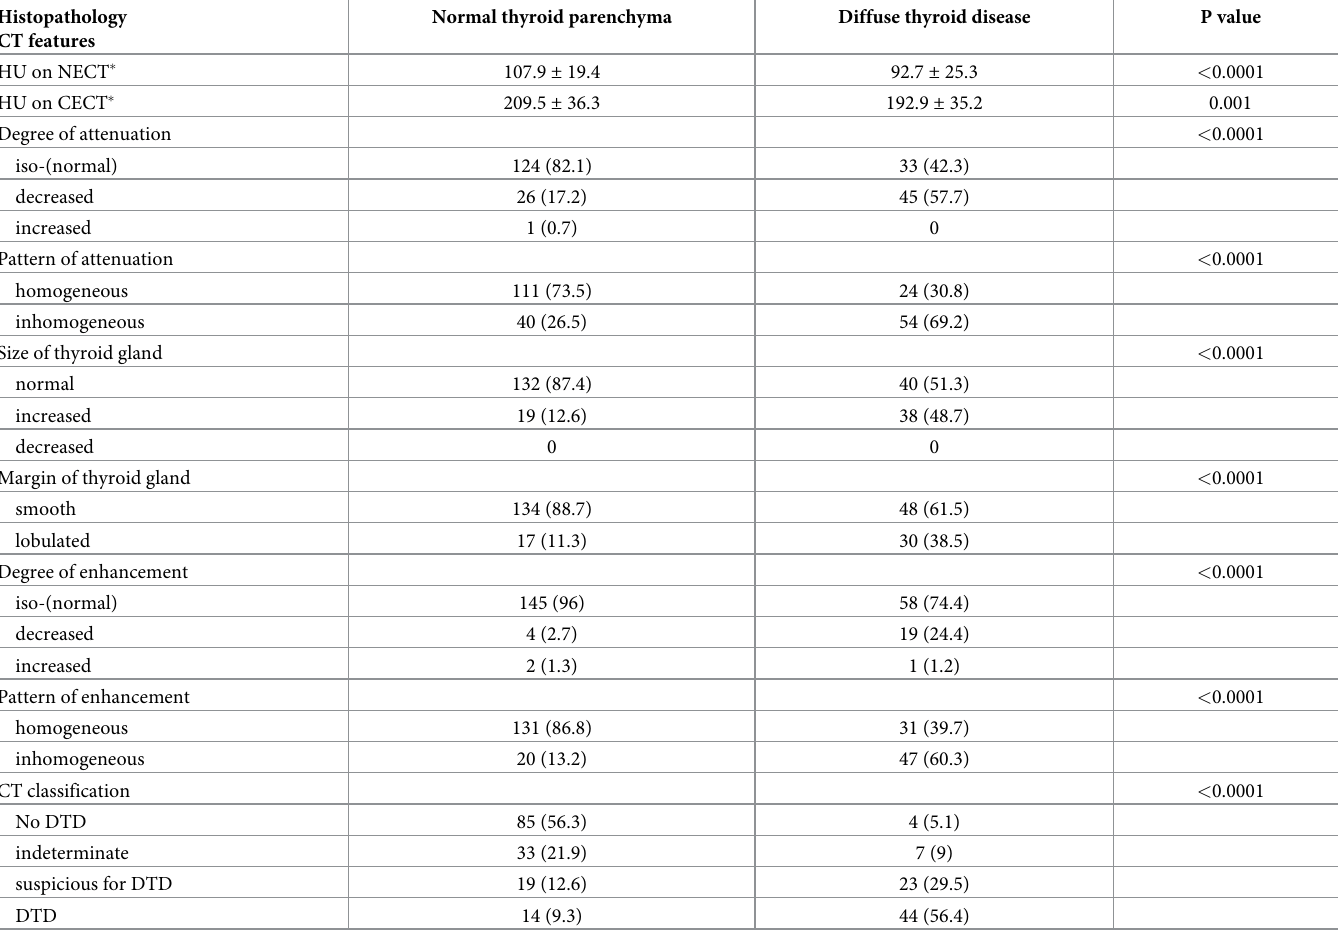
Table 1. Comparison of the computed tomography features of normal thyroid parenchyma and diffuse thyroid disease in 229 patients. Histopathology CT features